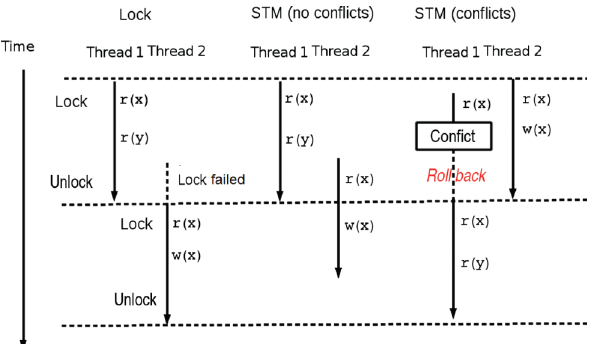
Figure 3: Two threads accessing shared data under three different scenarios; in the Lock scenario, it is not possible to have parallel readings due to the use of locks; in the STM scenario (no conflicts), the use of transactional memory does allow parallel readings within transactions; finally, in the STM scenario (conflicts), a task that wants to read within a transaction detects that another transaction has changed the state of the data, and performs a roll-back to obtain a consistent view of the